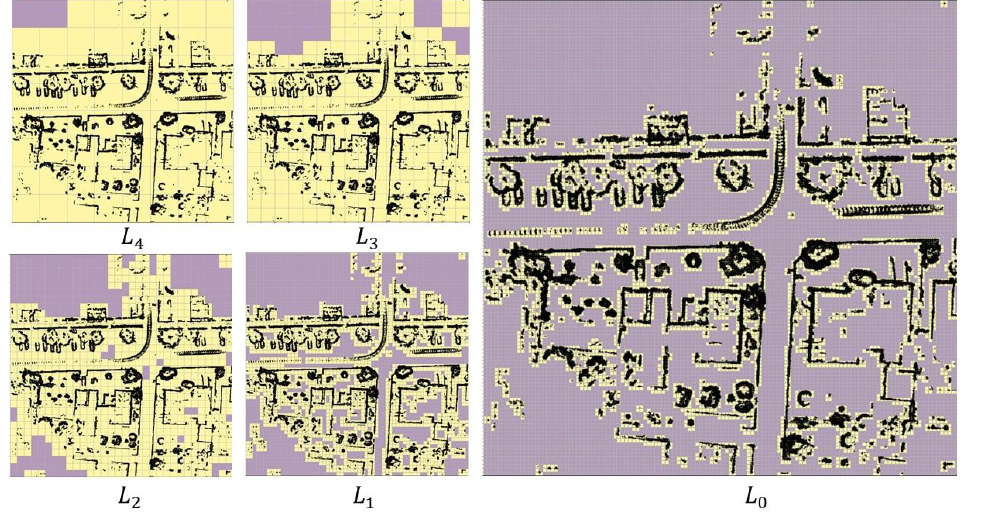
Figure 1. Examples of levels ( L 0 – L 4 ) for a section of the BEV map.Lighter yellow shaded grid cells correspond to cells with at least one point, and the darker shaded cells corresponding to cells with no points. The black points correspond to the map